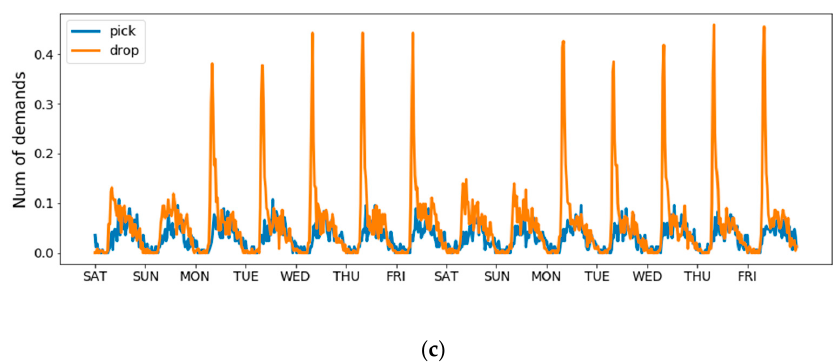
Figure 3. The demand in three distinct areas of Chengdu. All data has been normalized: ( a ) Grid (1, 2) Figure 3 . The demand in three distinct areas of Chengdu. All data has been normalized: a) Grid (1, 2) is near schools, residential; b) grid (11,3) is near a university and shopping malls; c) grid (3, 2) is near is near schools, residential; ( b ) grid (11,3) is near a university and shopping malls; ( c ) grid (3, 2) is near o ffi ce buildings, shopping